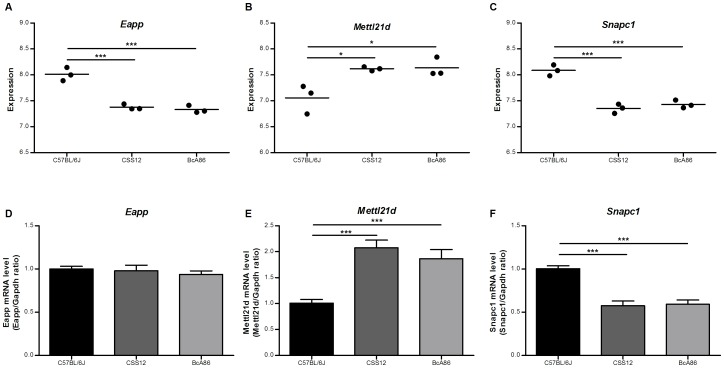
Selection of candidate genes within quantitative trait locus with expression differences.(A, B, and C) Dot plots of candidate genes from microarray analysis. Expression of Eapp and Snapc1 was higher in hyporesponsive C57BL/6J strain than both hyperresponsive strains, CSS12 and BcA86. Conversely, the expression of Mettl21d was higher in CSS12 and BcA86 compared to C57BL/6J. (D, E, and F) Quantitative RT-PCR validates the microarray expression differences of Mettl21 and Snapc1, but not of Eapp. Data are presented as mean ± SEM and statistical significance was calculated by one-way ANOVA and Bonferroni correction. n = 3 per strain for microarray and n>5 per strain for PCR; * and *** represents p<0.05 and p<0.001 respectively.